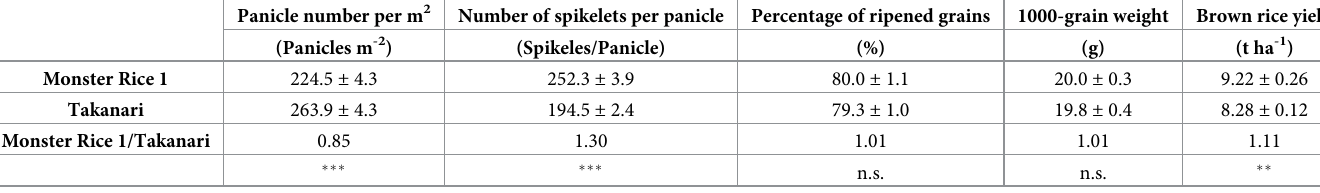
Table 2. Comparisons of yield components between Monster Rice 1 and Takanari in 2016.